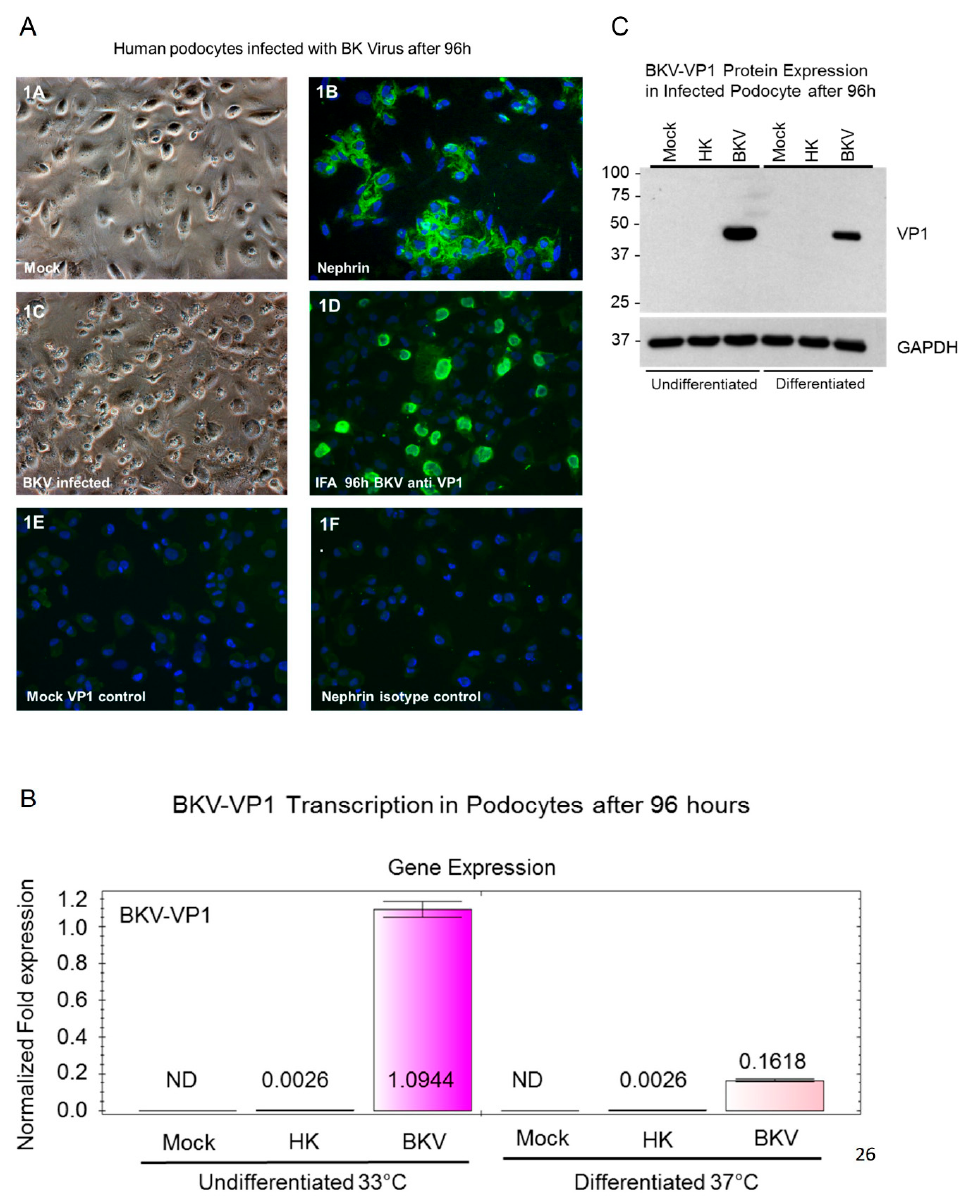
Figure 1. Immunofluorescence analysis of BKV replication in podocytes. ( A-1 ) Phase-contrast images of mock-infected podocytes, ( A-2 ) immunofluorescence staining of mock-infected glomerular podocytes stained with the nephrin antibody, ( A-3 ) BKV-infected podocytes 96 h post-infection ( A-4 ), immunofluorescence staining of BKV-infected podocytes with the BKV VP1 antibody 96 h post-infection ( A-5 ), and mock-infected podocytes stained with the BKV VP1 antibody ( A-6 ) mock-infected podocytes stained with the nephrin antibody. Nuclei were stained blue with 4 (cid:48) ,6-diamidino-2-phenylindole (DAPI). All images were obtained using a Nikon TE2000S microscope mounted with a charge-coupled device (CCD) camera at × 200 magnification. ( B ) VP1 Expression in BKV-Infected podocytes. qRT-PCR analysis of VP1 transcripts in mock-infected podocytes or podocytes exposed to heat-killed (HK) BKV or infected with wild-type BKV for 96 h. qRT-PCR analysis was performed on both undi ff erentiated podocytes cultured at 33 ◦ C and podocytes di ff erentiated for 7 days at 37 ◦ C. qRT-PCR results were normalized to GAPDH. ( C ) Western blot analysis of BKV VP1 protein expression in undi ff erentiated and di ff erentiated podocytes mock-infected or exposed to heat-killed (HK) BKV or infected with wild-type BKV for 96 h. Protein size markers are shown in kilodaltons. GAPDH is used as a protein loading